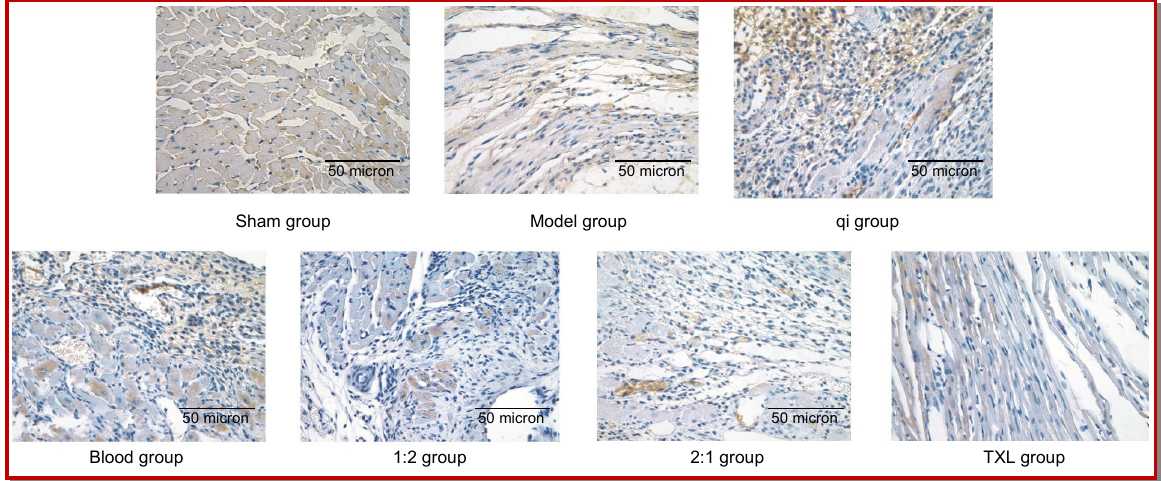
Figure 3: Endostatin protein expression at day